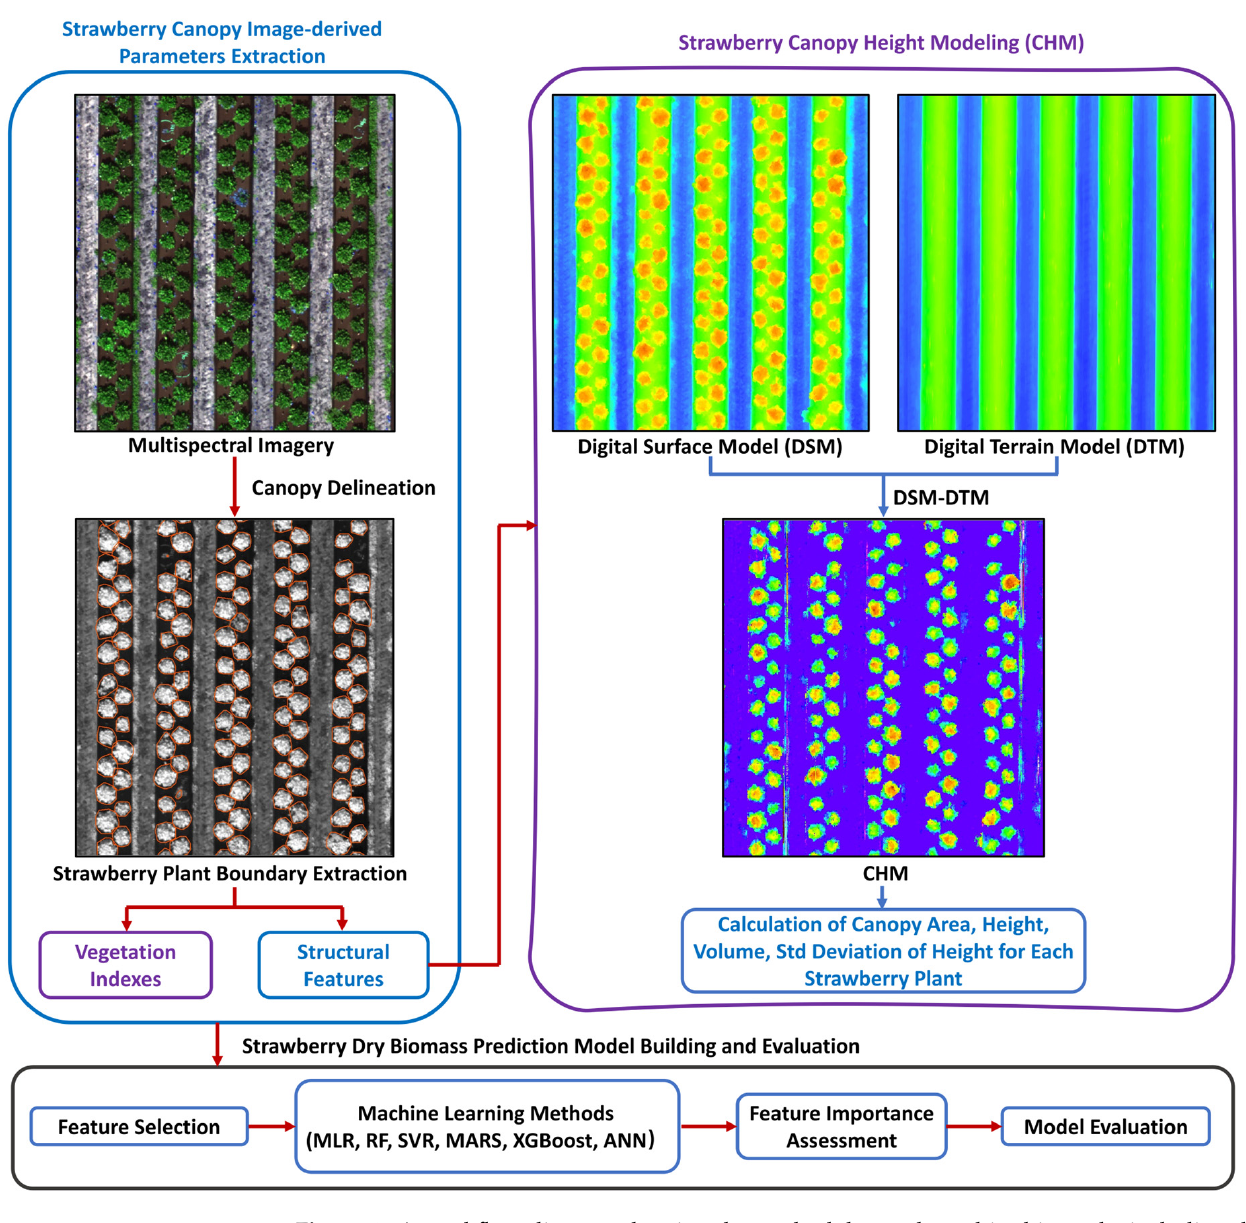
Figure 4. A workflow diagram showing the methodology adopted in this study, including data preprocessing, feature extraction and biomass predictive modeling.